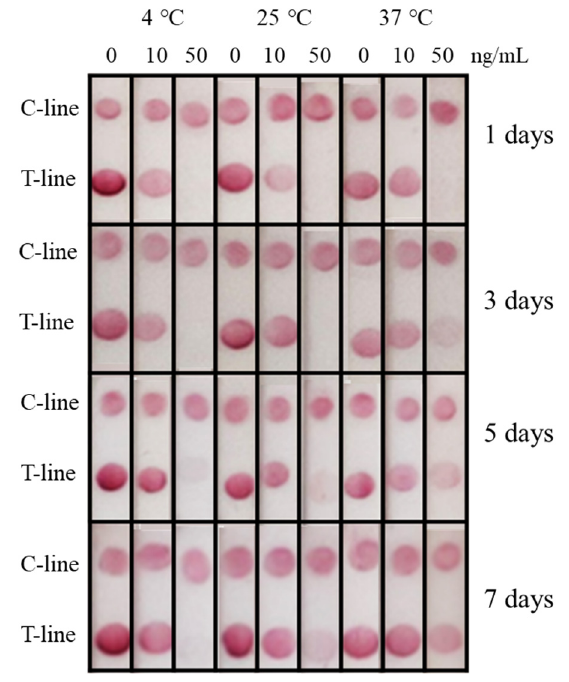
Figure 4. Stability of the immunochromatographic test strips for 1 days, 3 days, 5 days, 7 days at three temperatures (4 °C, 25 °C, 37 °C).